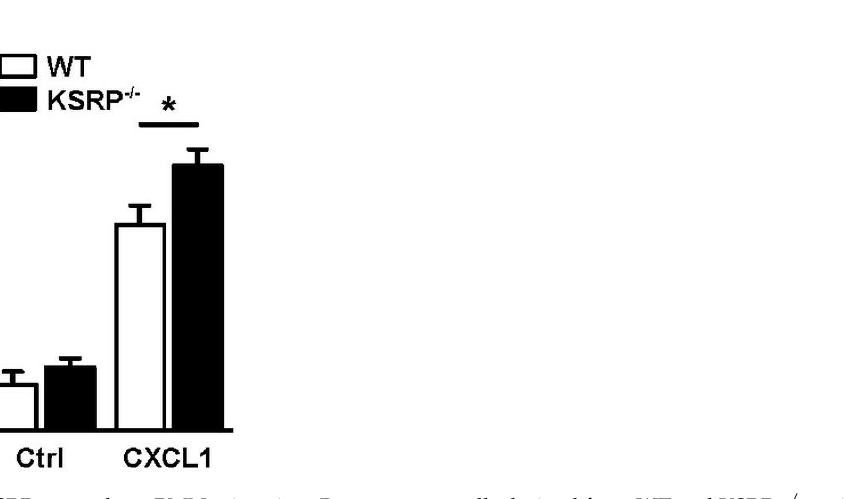
Figure 3. KSRP coregulates PMN migration . Bone marrow cells derived from WT and KSRP −/− mice towards C-X-C motif chemokine ligand 1 (CXCL1) were assessed in a transwell (Ø 5 µm) migration assay. Bone marrow derived cells were cultivated in 24-well plates with Iscove’s Modified Dulbecco’s Medium supplemented with 5% FCS, 1% penicillin/streptavidin, 2 mM L-Glutamin and 50 µM β -Mercaptoethanol, in a final concentration of 5 × 10 5 cells/mL. Seeded cells were stimulated with 250 ng/mL CXCL1. Control (Ctrl): w/o chemokine. After incubation for 4 h at 37 °C and 10% CO 2 , the frequency of migrating Ly6G + PMN was assessed by flow cytometric analysis (mean + SEM, n = 6; * p < 0.05).